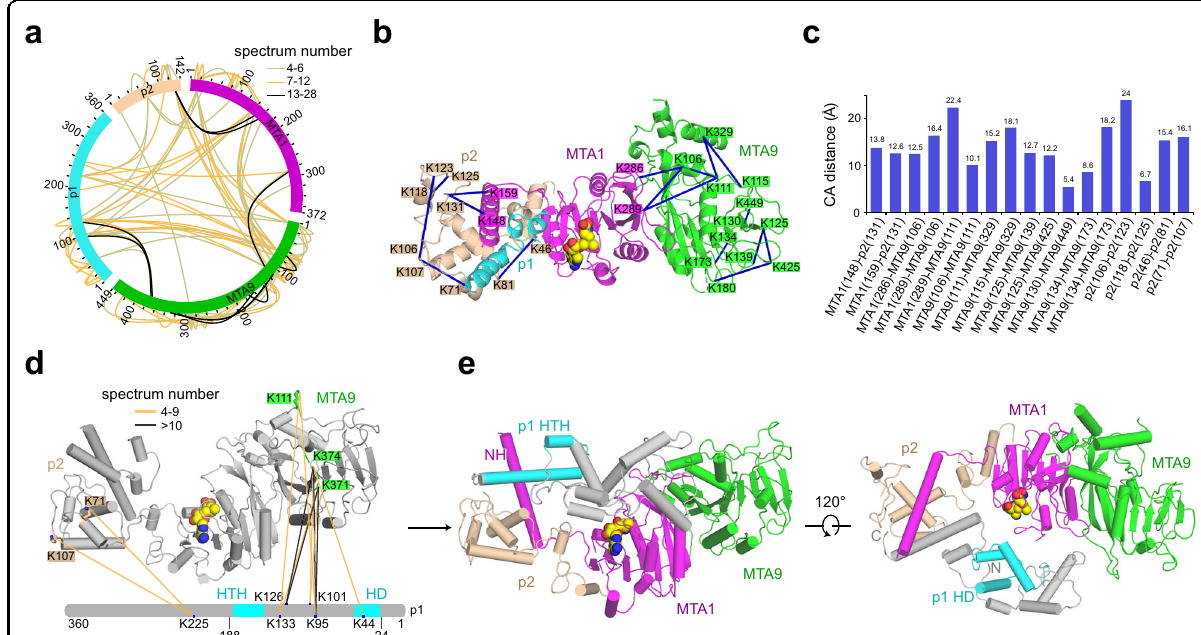
Fig. 4 Integrative modeling of a near-complete MTA1 complex based on CXMS data and AlphaFold prediction. a The 108 non-redundant cross-links identi fi ed in the MTA1 complex shown in a circle plot. The numbers of the corresponding spectra of each cross-link were indicated by the colors of the line. Cross-links were fi ltered with the following criteria: FDR < 0.05 at the spectrum level, supervised vector machine (SVM) value < 1 × 10 – 2 and spectral counts ≥ 4. b Cross-links mapped on the structure of the MTA1 complex. Residues in MTA1, MTA9, and p2 involved in the cross- linked pairs are shown in magenta, green, and wheat rectangles, respectively. SAM is illustrated as a yellow space- fi lling representation. c The distance distribution of all cross-links mapped to the structure of the MTA1 complex. The 26 Å cutoff value was used to fi lter the cross-links, well below the 35-Å upper limit. d The inter-subunit cross-links between MTA1 – MTA9 – p2 and p1 in the MTA1 complex. HD, homeobox-like domain; HTH, helix-turn- helix-like motif. e The modeled near-complete MTA1 complex. MTA1, MTA9, p1, and p2 are shown in magenta, green, gray, and wheat, respectively. The p1 HD (residues 25 – 71) and HTH (residues 152 – 183) are highlighted in cyan in the two different views, respectively. Residues 24 – 188 of p1 was docked to MTA1 – MTA9 – p2 in the MTA1